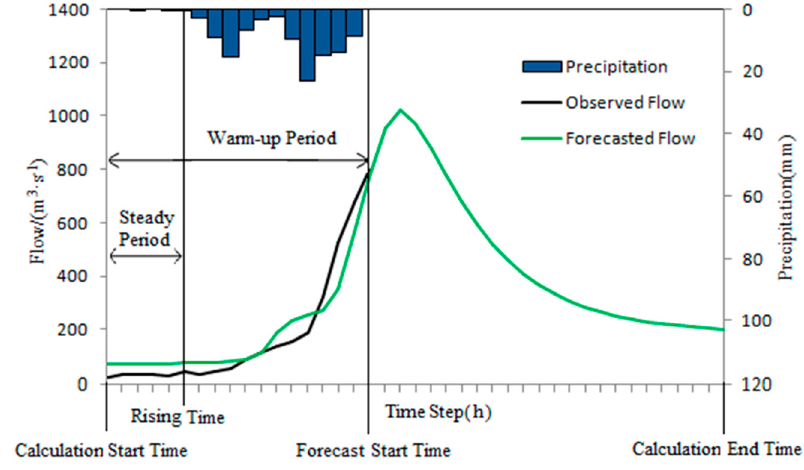
Figure 3. A typical flood forecasting process.